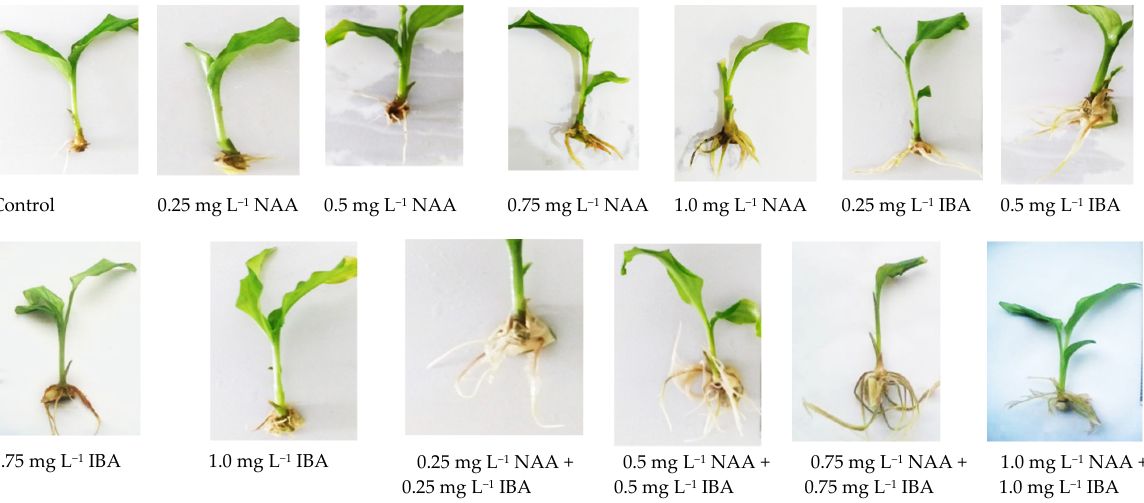
Figure 4. Effect of growth regulators of S. thorelii Gagnep root development.